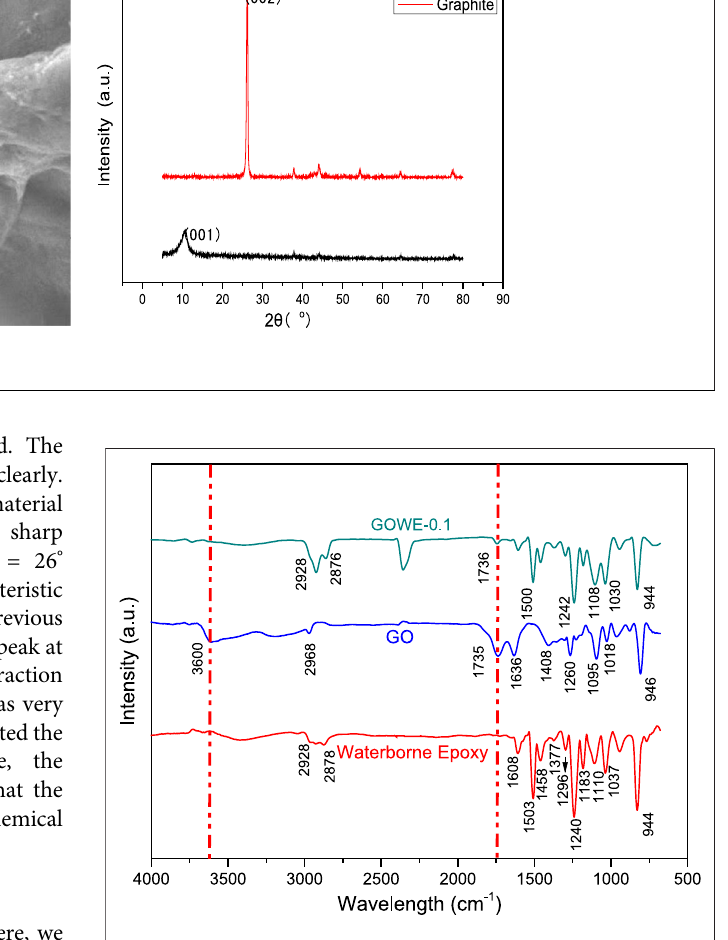
FIGURE 9 | Fourier transform infrared spectra of GO, waterborne epoxy (control), and